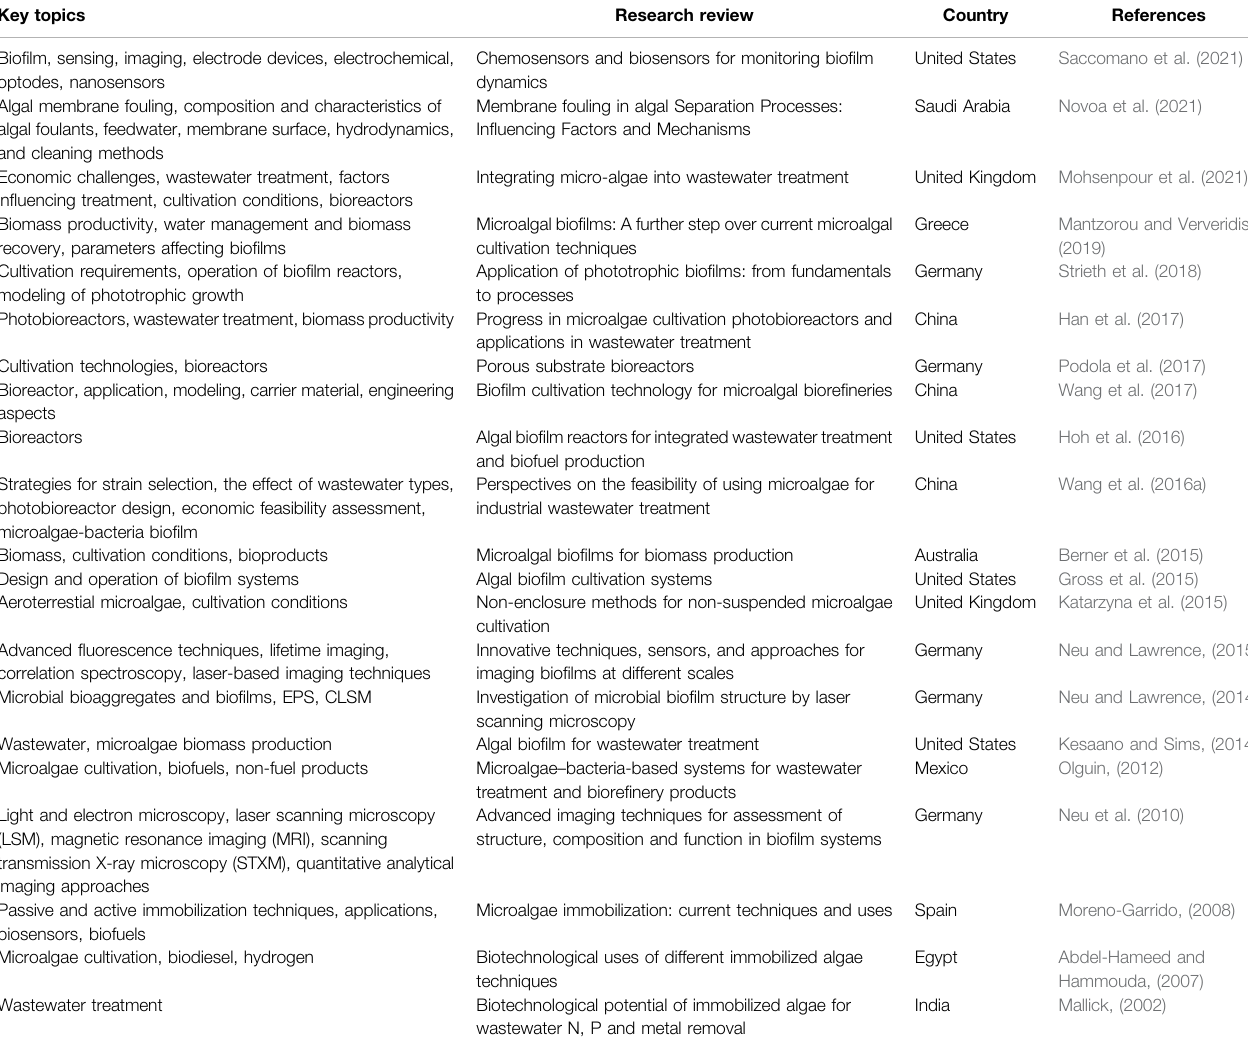
TABLE 1 | Compilation of featured informative published reviews in the research fi eld of microalgae bio fi lms on topics as cultivation, reactor designs, analysis techniques, applications and promising